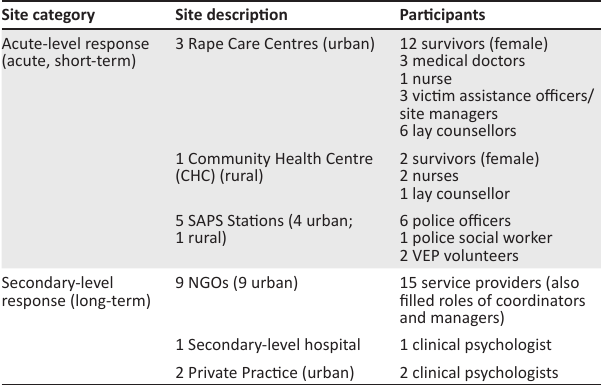
TABLE 1: Description of study sites and